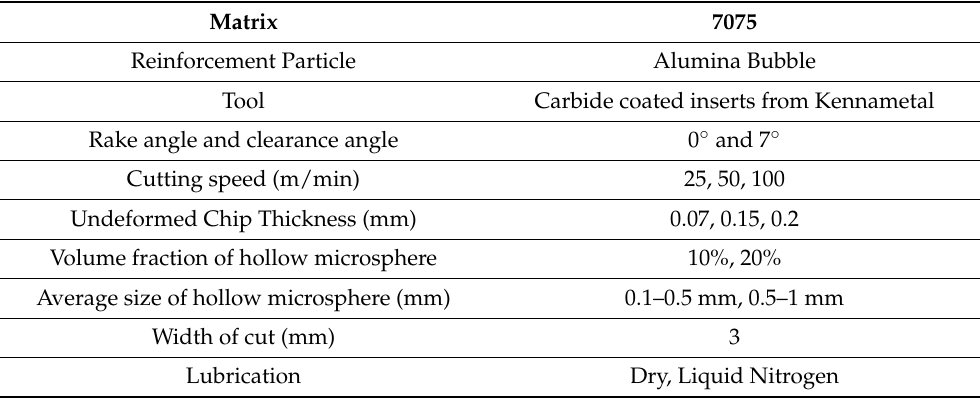
Table 4. Machining factors for 7075 based syntactic